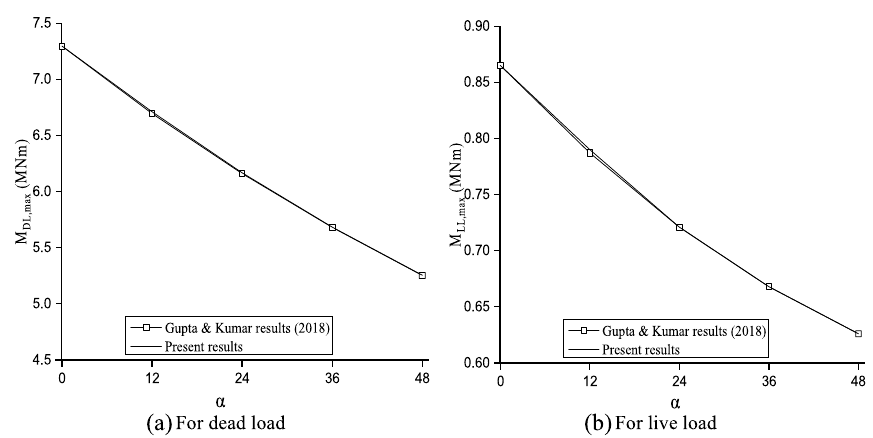
Fig. 4 Variation of MBM with curve angle in inner girder. a For dead load. b For live